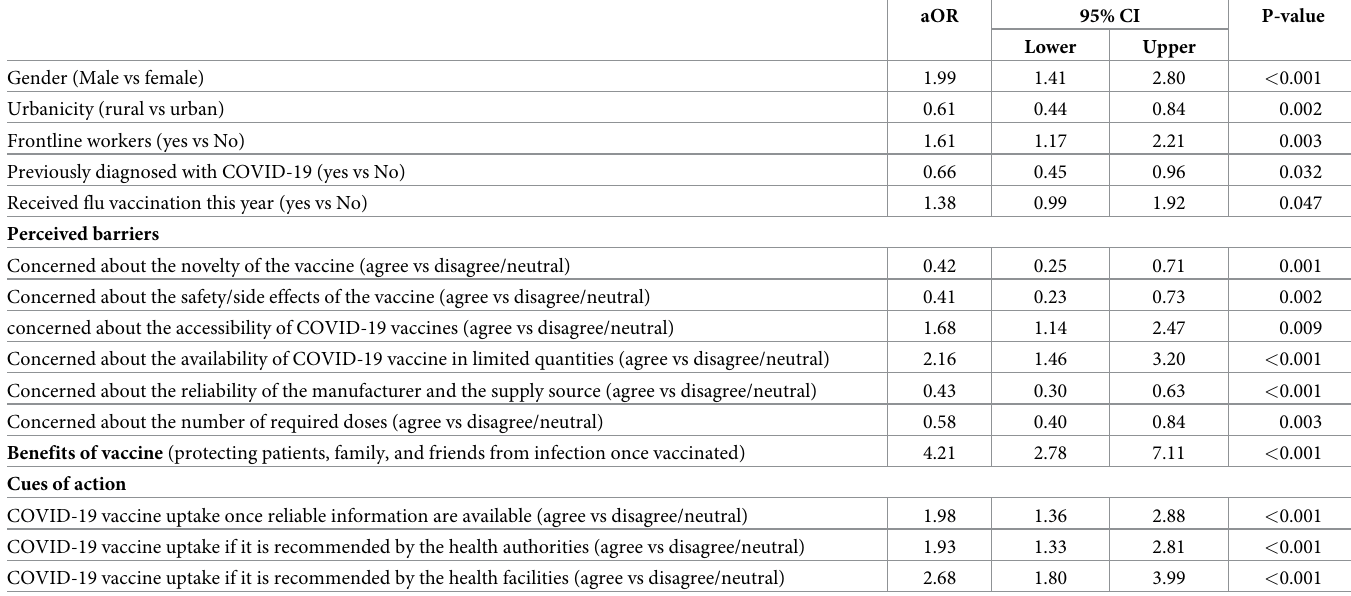
Table 4. Factors associated with the willingness to take COVID-19 vaccines among HCWs in Lebanon (N =